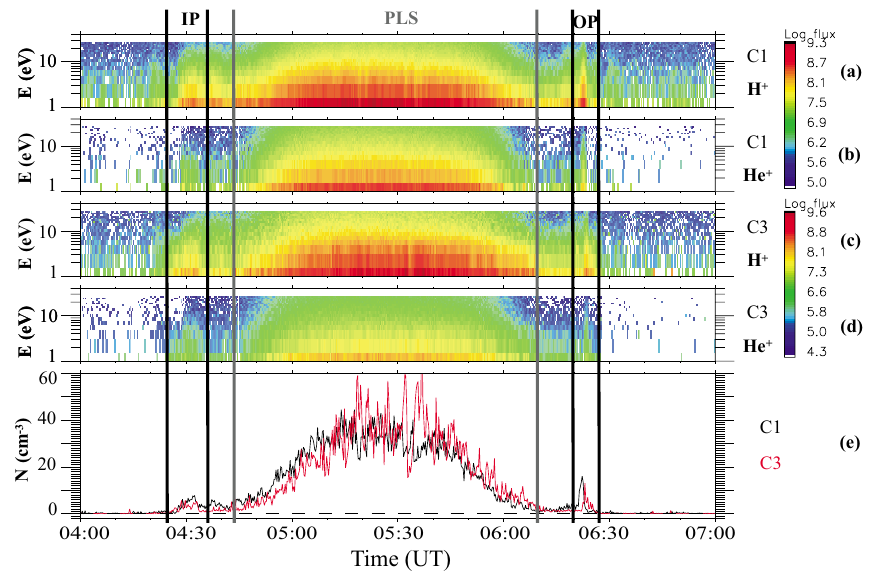
Fig. 15. Data from the CIS instrument in RPA mode on 11 April 2002 during the plasmasphere crossing of C1 and C3 (similar as Fig. 10).